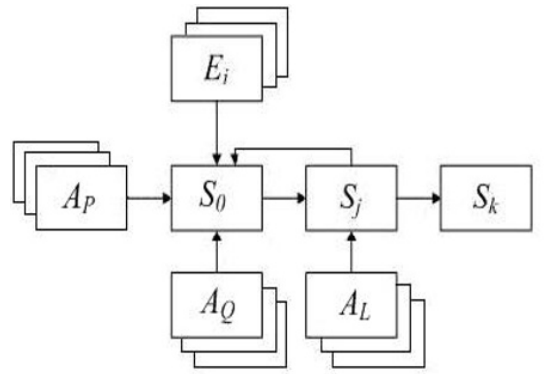
Fig. 1. The general research scheme for assessing the state of the fuel and energy complex from the point of view situational